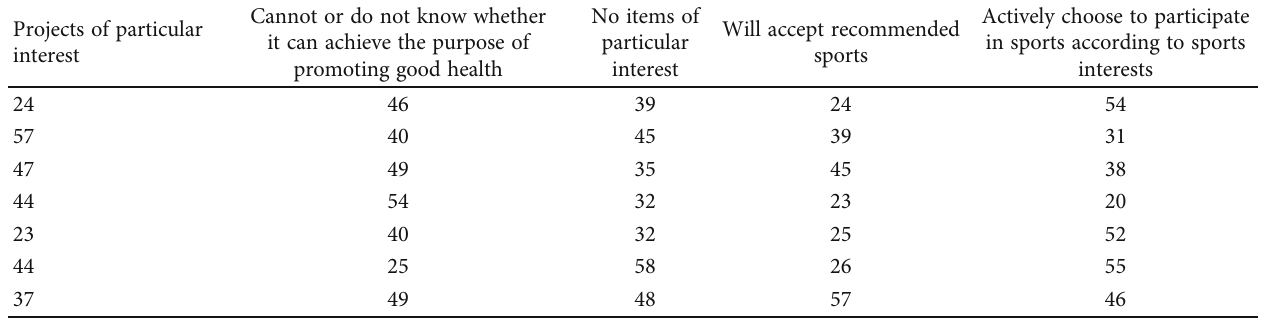
Table 3: Objective